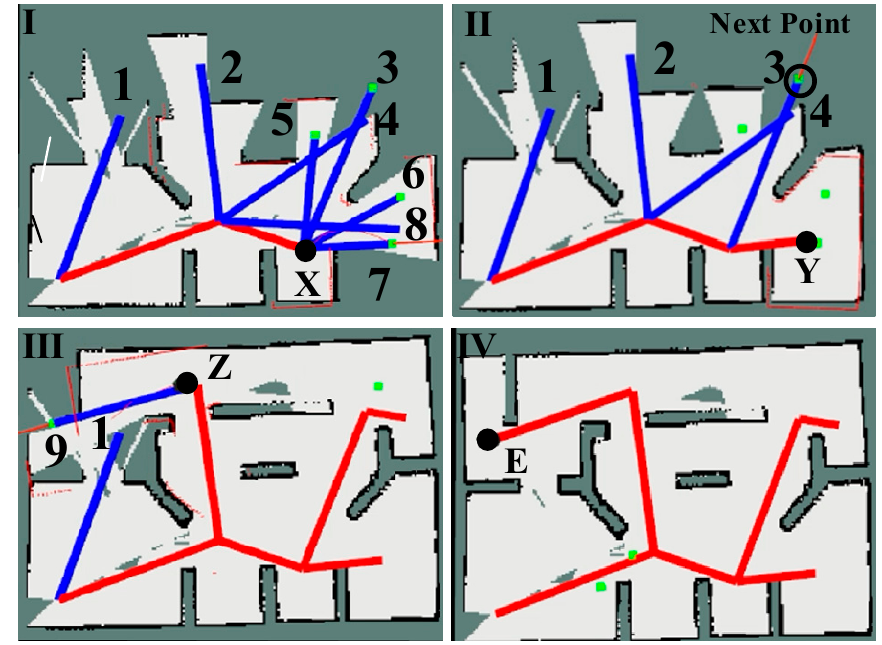
Figure 8. Process of building the TGHM.